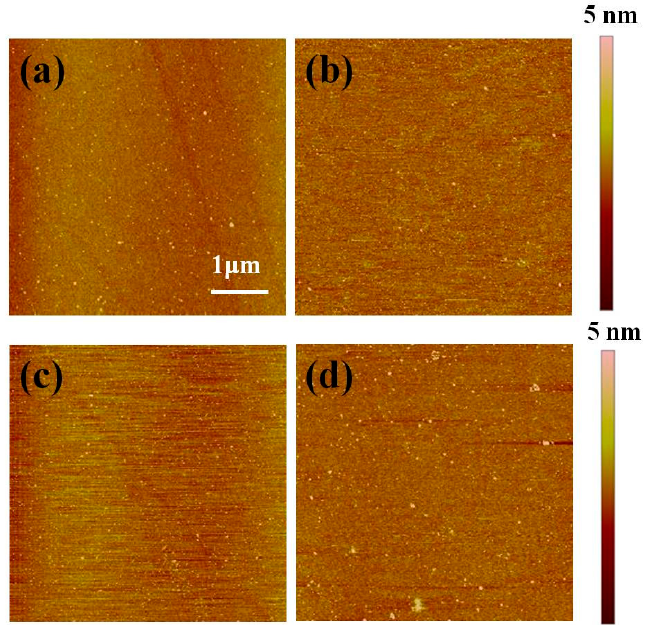
Figure 6. Images of OTS ( a ) before and ( c ) after vacuum annealing at 573 K; AFM images of PTES ( b ) before and ( d ) after vacuum annealing at 573 K.